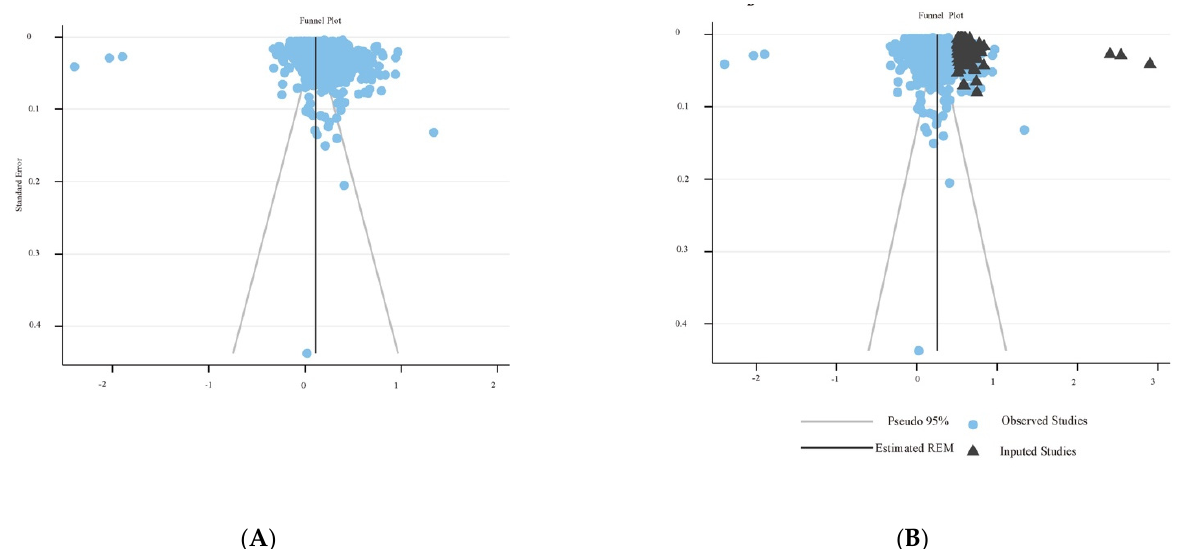
Figure A2. Funnel diagram generated ( A ) by Egger’s test and ( B ) funnel diagram after trim-and-fill.